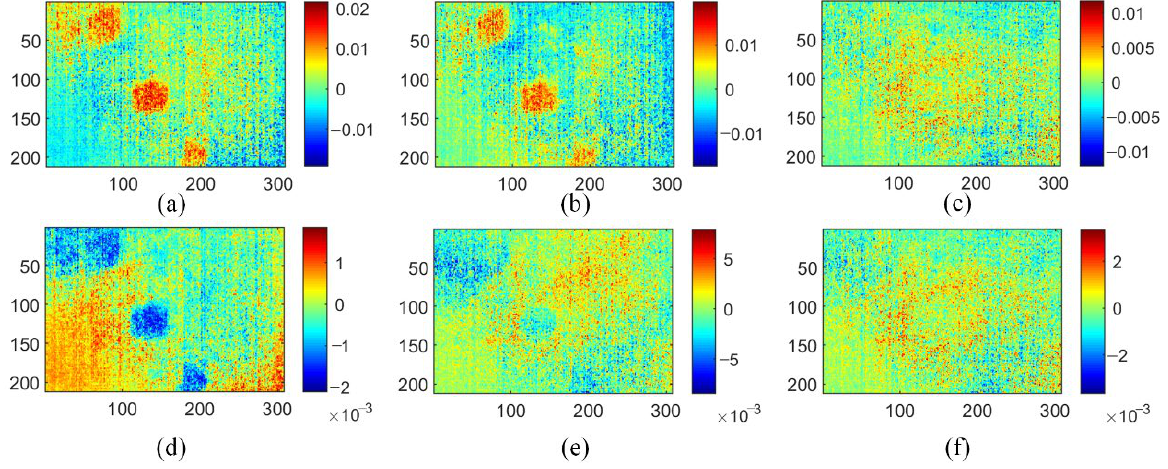
Figure 10. Analysis results of GMLT method on three-defective CFRP sample: ( a ) IV1; ( b ) IV2; ( c ) IV3; ( d ) IV4; ( e ) IV5; ( f ) IV6.